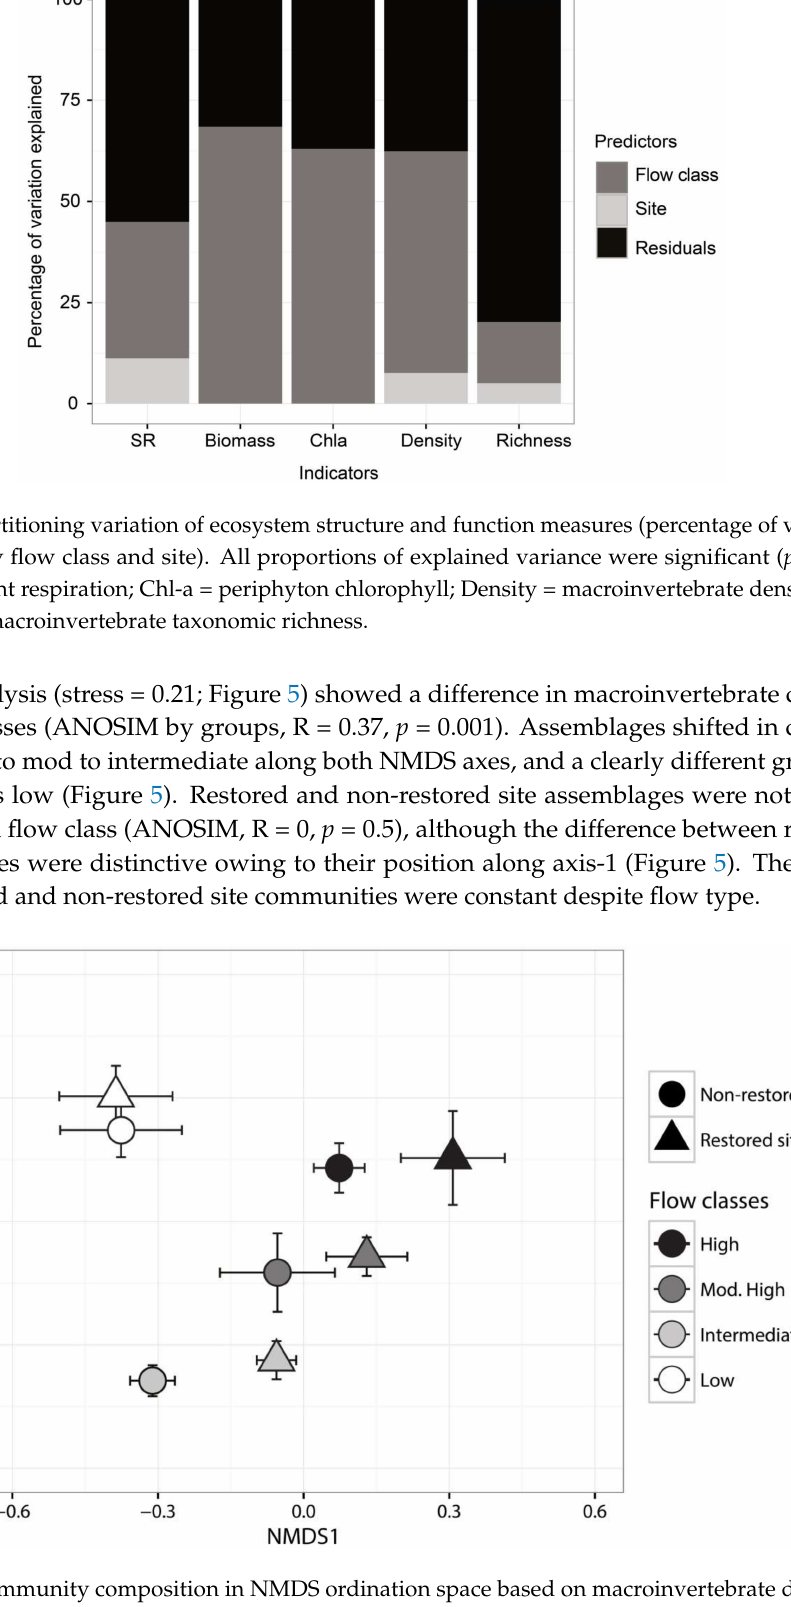
Figure 5. Community composition in NMDS ordination space based on macroinvertebrate densities. Symbols represent samples for different flow classes in restored or non-restored